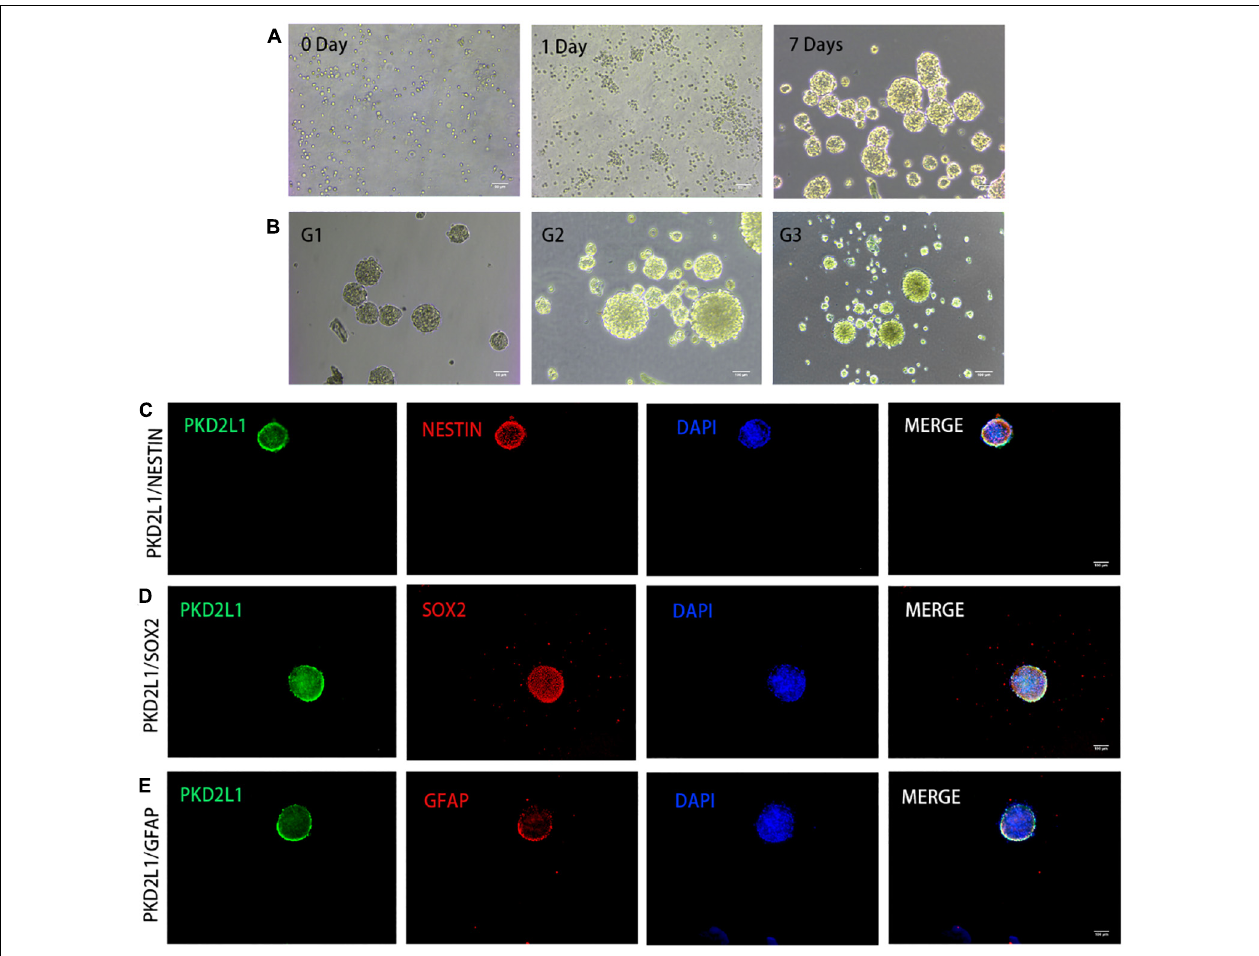
FIGURE 3 | CSF-cNs formed neurospheres and expressed neural stem cell markers. (A,B) The growth of neurospheres in different stages. (A) 0–7 days in the first passage. (B) Passage 1–3. (C–E) Immunofluorescence analysis showing that neurospheres expressed neural stem cell markers for nestin (C) , Sox2 (D) , and GFAP (E) .